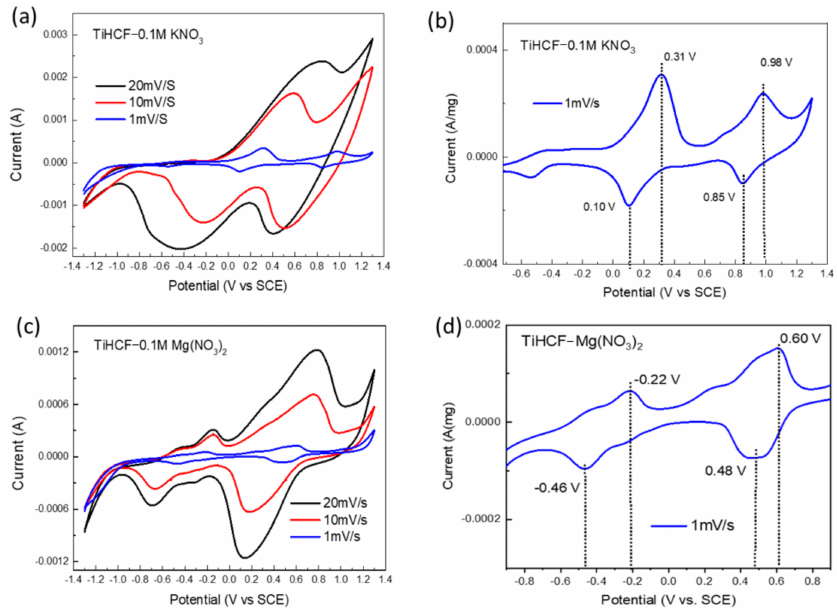
Figure 5. Three-electrode system: ( a , c ) CV curves of TiHCF in 0.1 M KNO 3 and 0.1 M Mg(NO 3 ) 2 electrolyte at the different scan rate; ( b , d ) CV curves of TiHCF in 0.1 M KNO 3 and 0.1 M Mg(NO 3 ) 2 at 1 mVs − 1 , using mass normalized current.